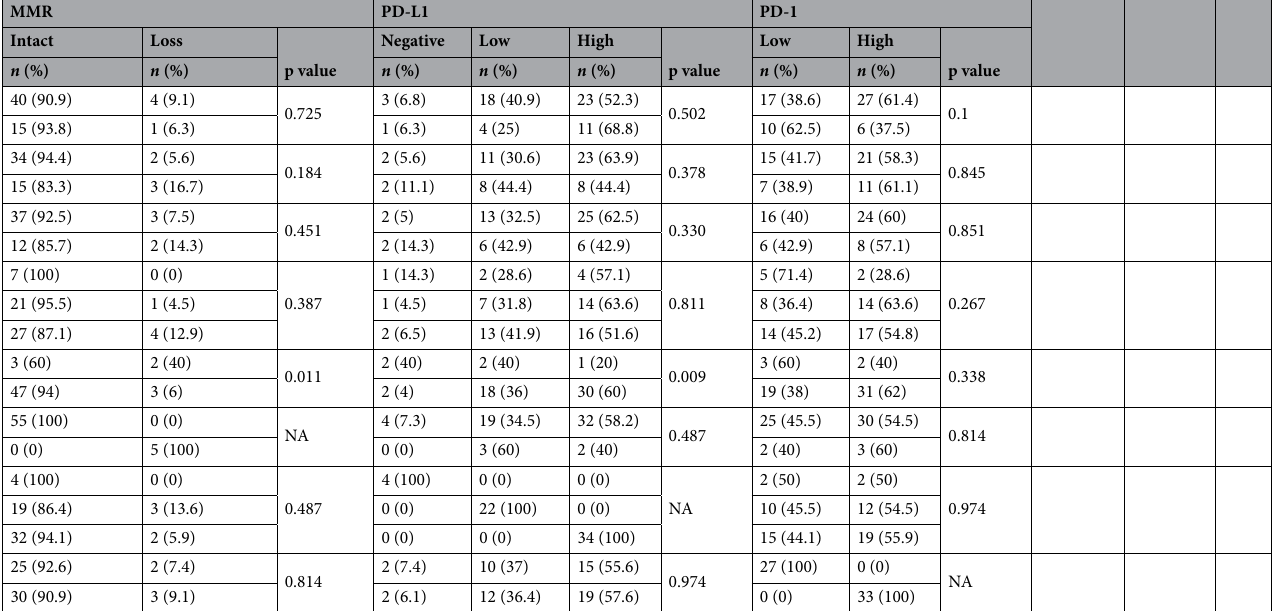
Table 2. Clinicopathologic features of patients in relation to p16, MMR status, PD-L1 and PD-1 expression in tumor infiltrating lymphocytes. HPV human papilloma virus, MMR mismatch repair proteins,